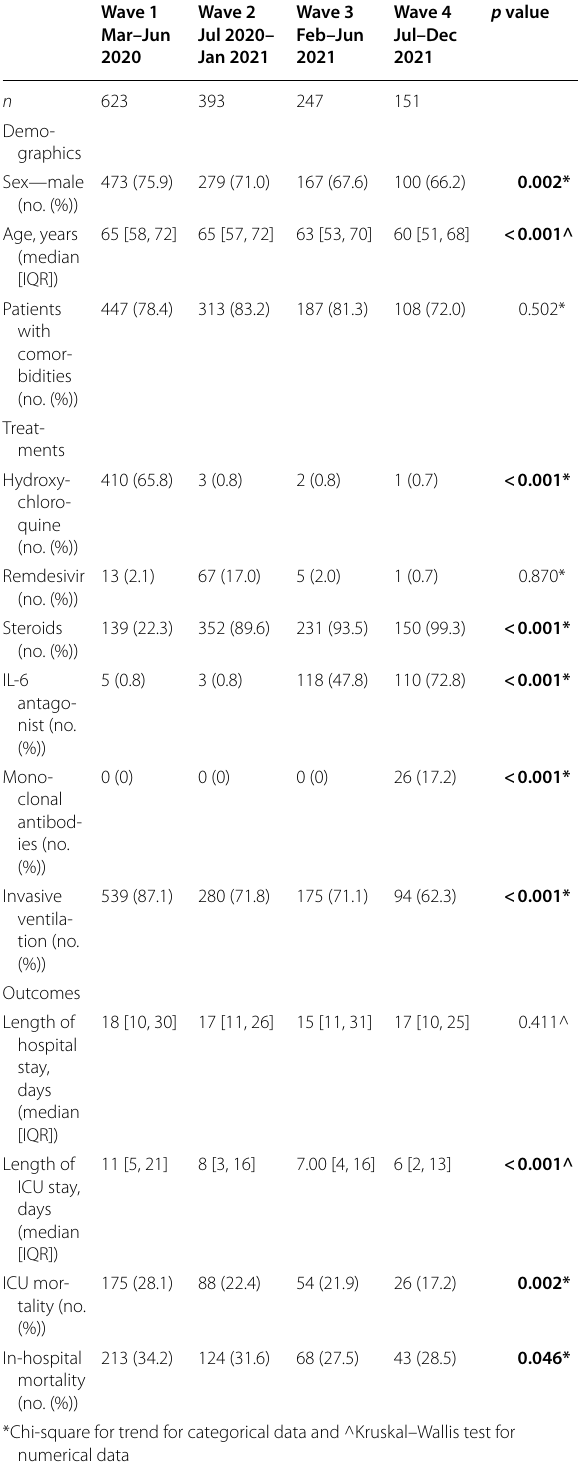
Table 1. Clinical characteristics, treatments and